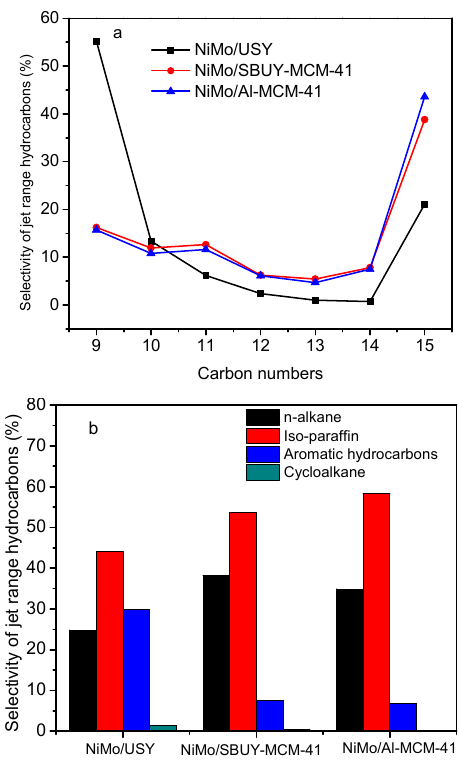
Figure 4. ( a ) Selectivity for the formation of hydrocarbons with different carbon numbers over different catalysts. ( b ) Selectivity for the formation of various jet-fuel-range hydrocarbons using different catalysts. Reaction conditions: 380 °C, 3 MPa, 500